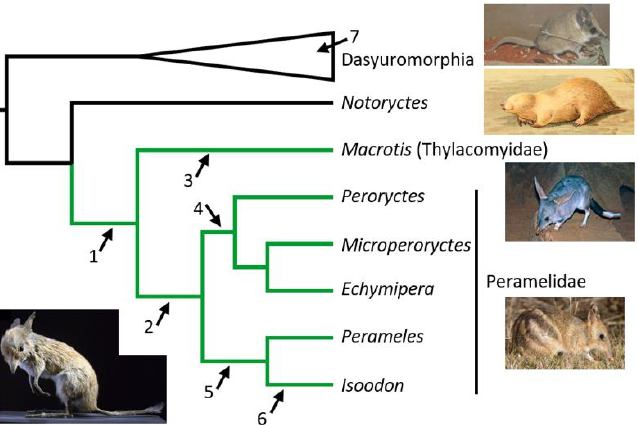
Figure 1. Peramelemorphia phylogeny (in green) for all extant genera, with dasyuomorphian and Notoryctes outgroups. The potentially extinct Rhynchomeles may fall within Echymipera [16]. Placements of Chaeropus in molecular and combined molecular-morphological studies; 1. Westerman et al. [12,14], Kear et al. [17], Travouillon and Phillips [16], Beck et al. [18], 2. Meredith et al. [13], Travouillon et al. [20], 3. Travouillon and Phillips [16], 4. May-Collado et al. [15], 5,6. Travouillon et al. [6], 7. Upham et al. [19]. Note that alternative analyses in some studies favoured differing placements. Images: Left; Chaeropus yirratji (Muséum national d’ histoire naturelle, Paris), Right, from the top; Sminthopsis crassicaudata (A Couch), Notoryctes typhlops (R Lydekker), Macrotis lagotis (B Dupont), Perameles gunnii (JJ Harrison).